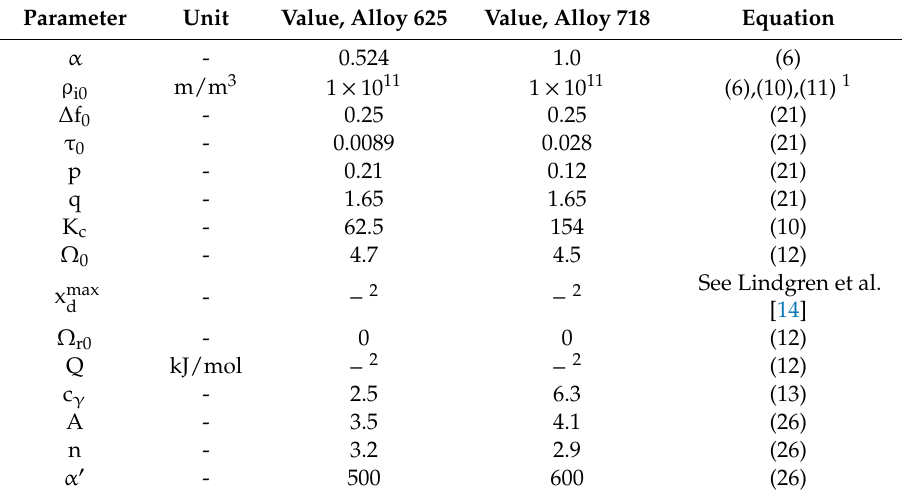
Table 4. Parameter values obtained from the optimization